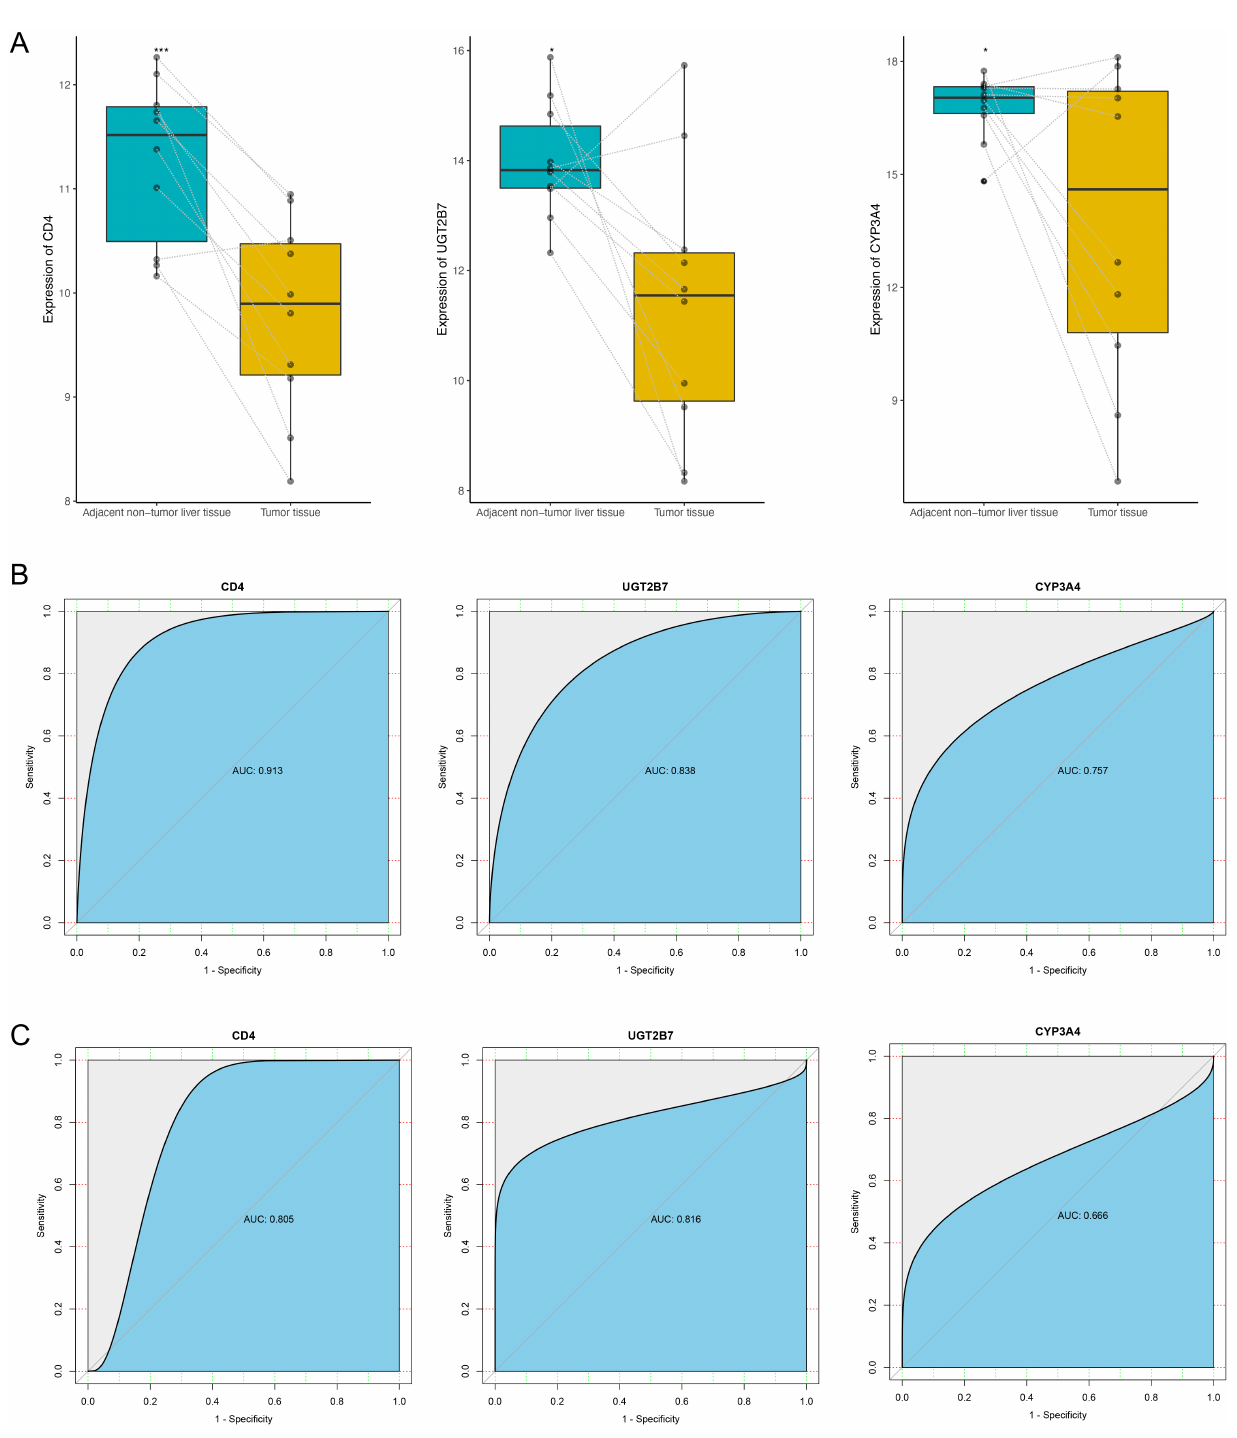
Figure 5. Hub gene verification and ROC analysis indicated that CD4 , UGT2B7 , and CYP3A4 may be the potential diagnostic biomarkers of NAFLD-HCC. (A) The differential expression of CD4 , UGT2B7 , and CYP3A4 in paired tumor tissues and adjacent tissues of GSE164441. (B) ROC analysis of CD4 , UGT2B7 , and CYP3A4 in GSE164760. (C) ROC analysis of CD4 , UGT2B7 , and CYP3A4 in GSE164441. HCC, hepatocellular carcinoma; NAFLD, non-alcoholic fatty liver disease; ROC, receiver operating